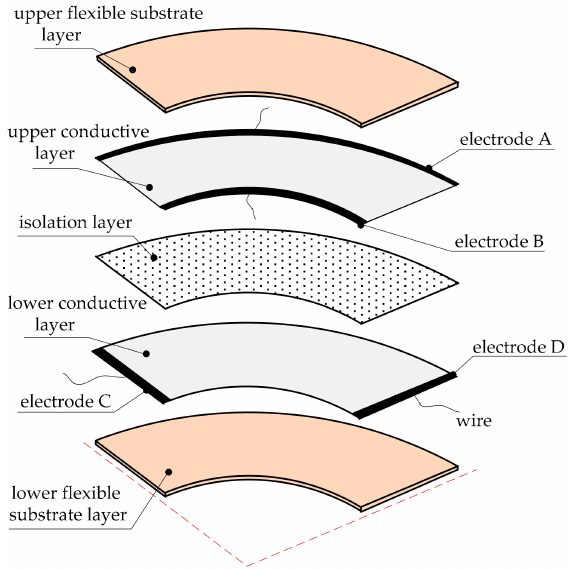
Figure 7. The structural model of the